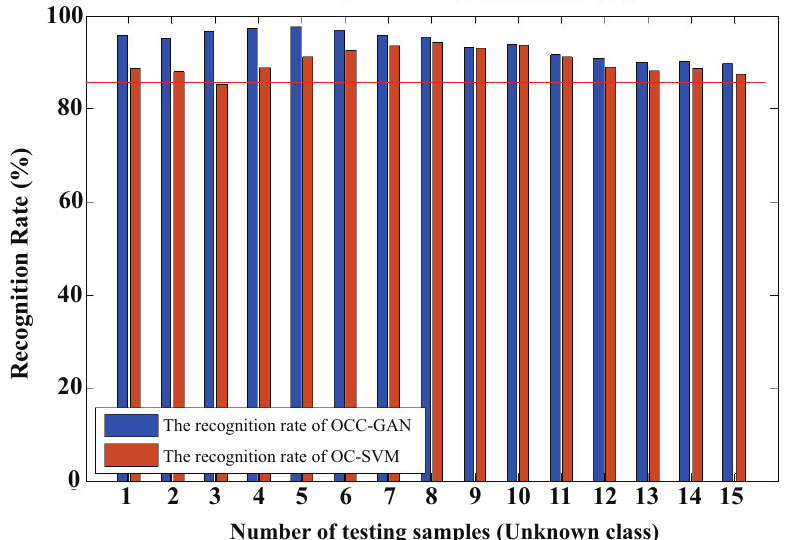
Figure 16. Comparison of the OC-SVM and OCC-GAN algorithms.